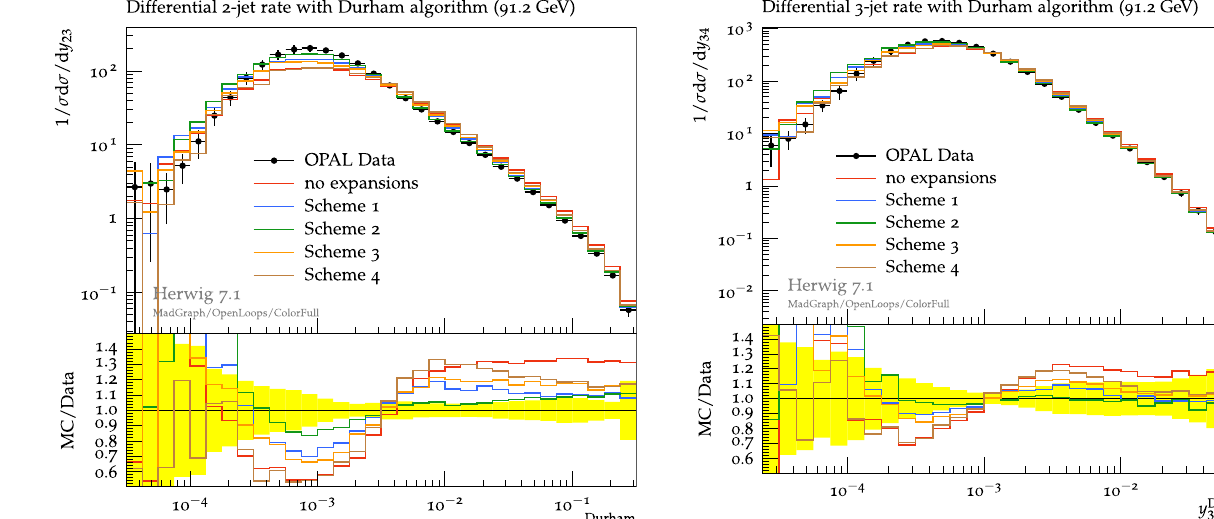
Fig. 9 To show the effects of choosing different schemes of history weight expansions as described in Sect. 4.4. We compare to data from [62]